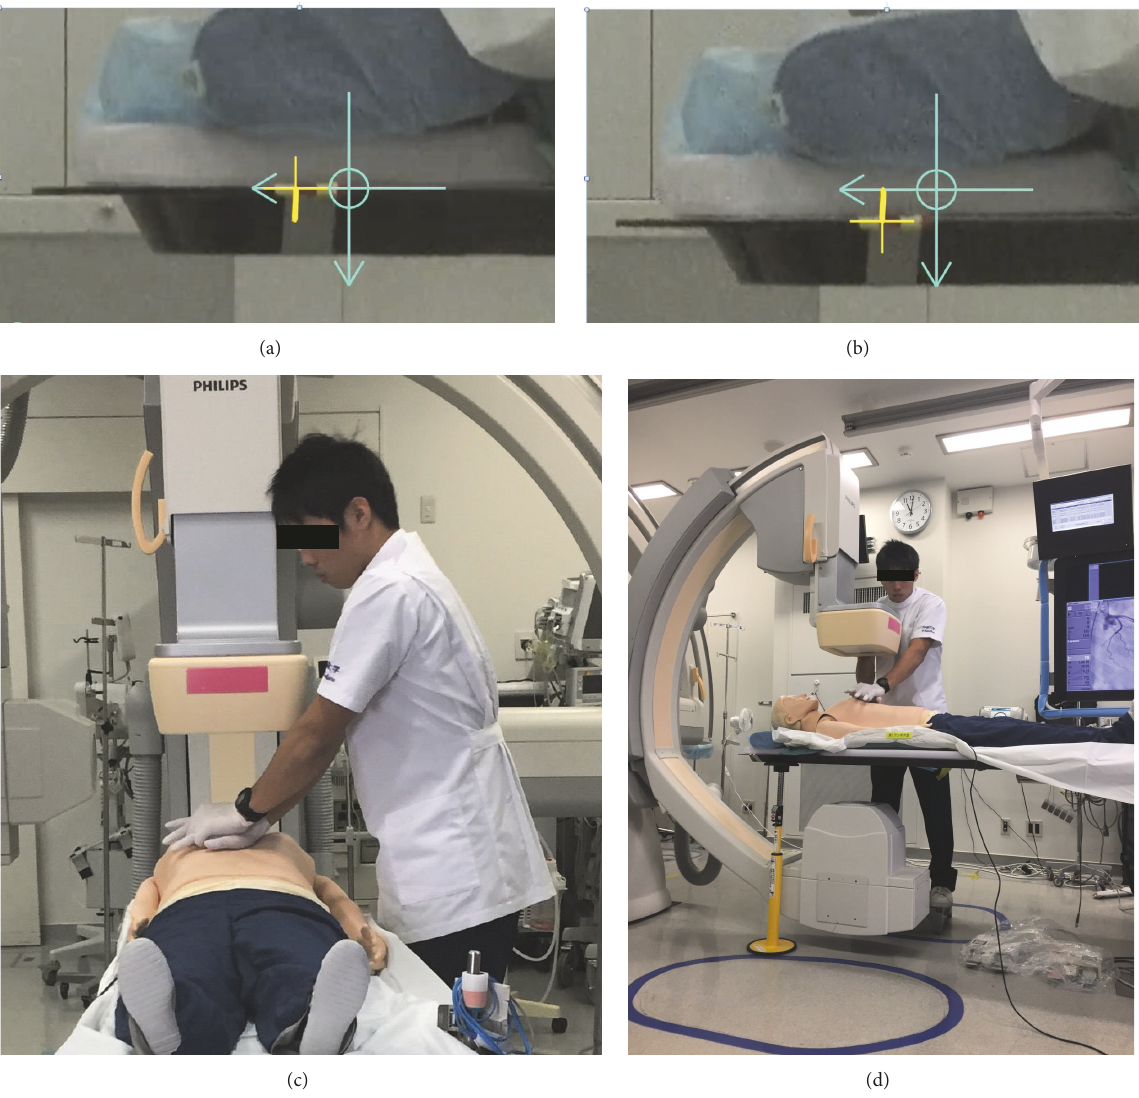
Figure 2: Alignment of the video camera during CPR simulation and photographs of the procedure. (a) Yellow crosshair mark indicates the height of the angiography table at the time of a fully released chest compression. (b) Distance between the light blue crosshairs and yellow crosshairs indicates deflection of the catheterization table during a chest compression. (c) Position of the arms when the participant performs CPR on the catheterization table. (d) A CPR procedure performed with the use of a table-stabilizing stick under the catheterization table. The chest of the mannequin is located between the X-ray tube and the flat panel detector. Therefore, it is impossible to push the chest